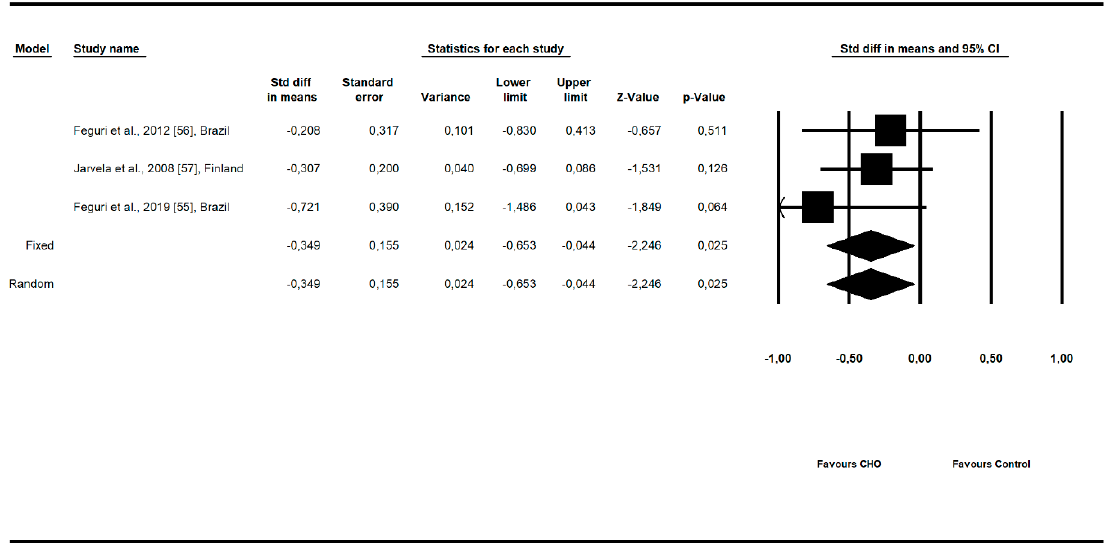
Figure 6. An effect size standardized mean difference, for exogenous insulin units (IU) in intensive care unit (ICU) postoperatively in patients taking oral carbohydrates (OCH) drinks vs. controls. Std diff in means ‐ standardized mean difference; 95%Cl – 95% confidence interval.